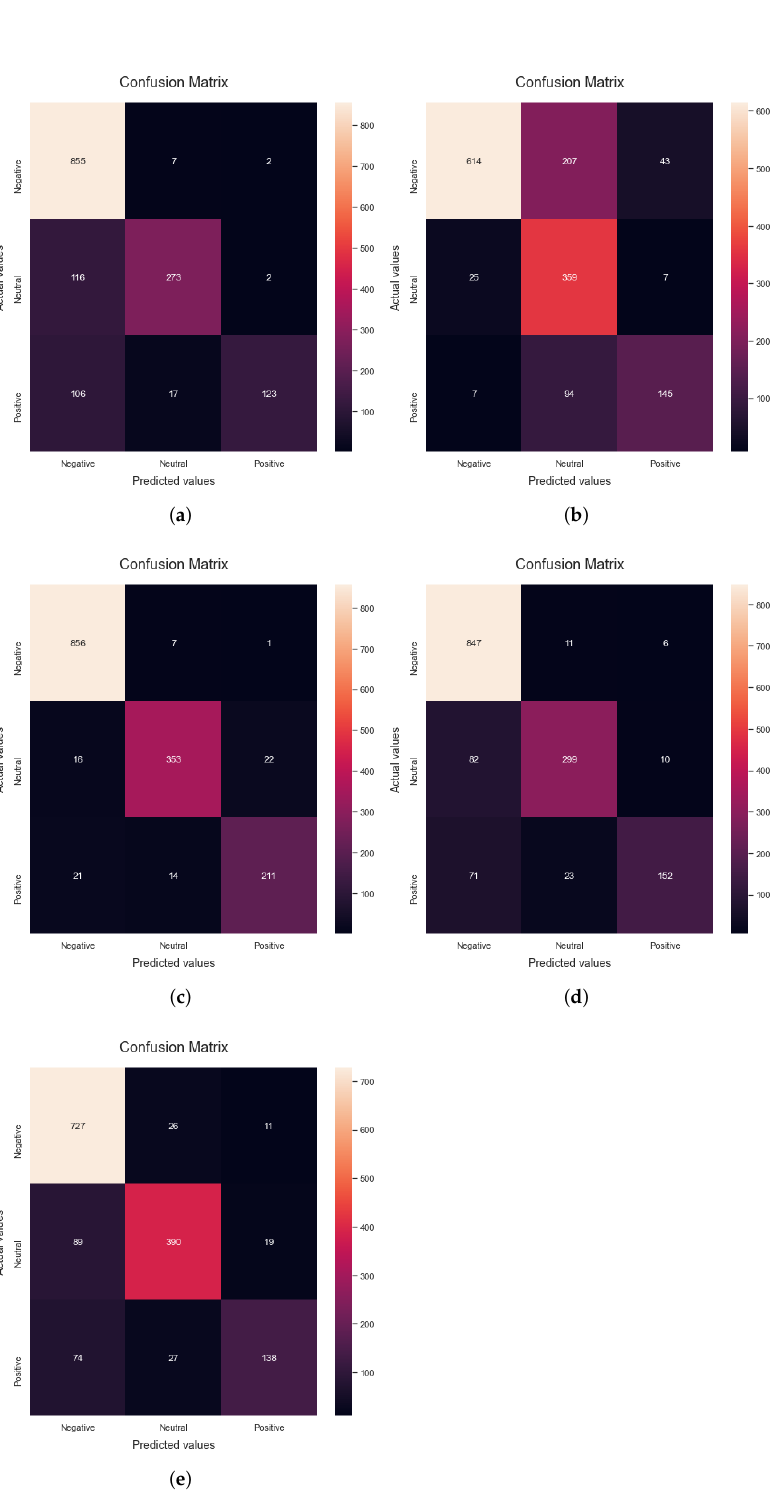
Figure 12. Confusion matrix for Sinopharm Dataset ( a ) using Random Forest ( b ) Naive Bayes ( c ) Decision Tree ( d ) Logistic Regression ( e )